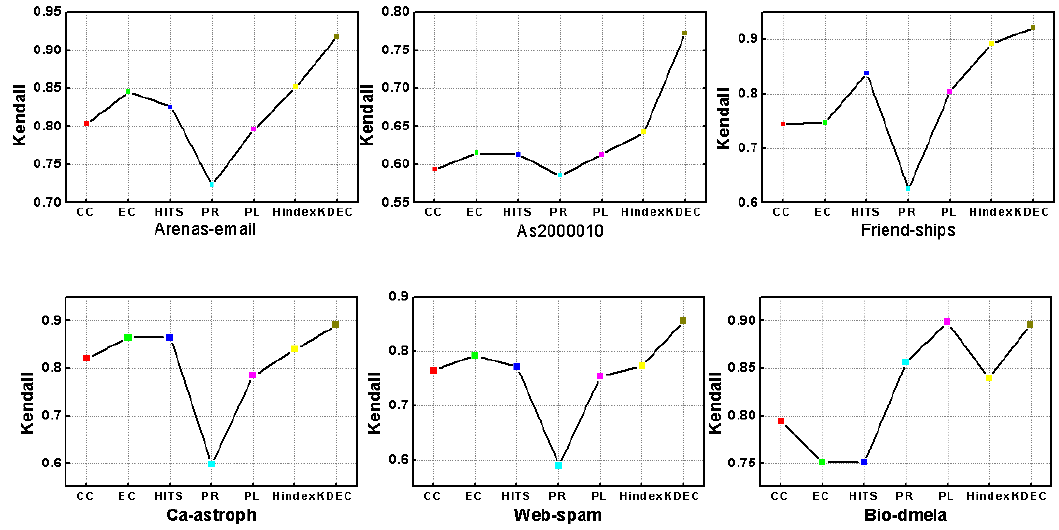
Figure 4. The results of all comparison algorithms on each real-world network, obtained through 1000 independent